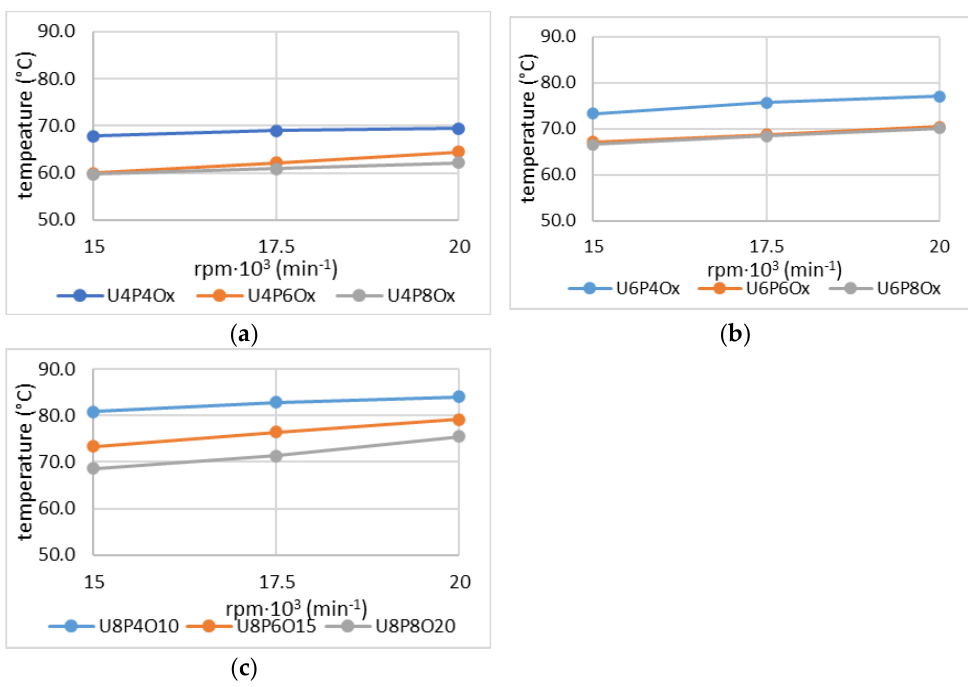
Figure 7. Dependence of temperature on change in revolutions, feed speed, and radial depth of cut (( a ) — radial depth of cut 4 mm, ( b ) — radial depth of cut 6 mm, ( c ) — radial depth of cut 8 mm).